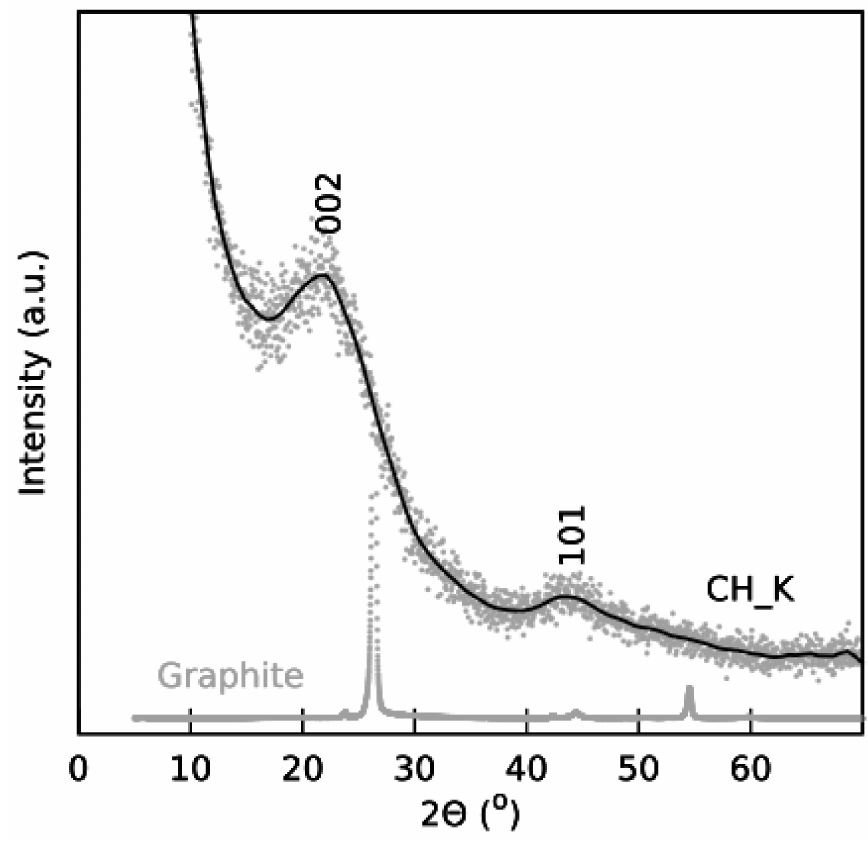
Figure 2. XRD patterns of